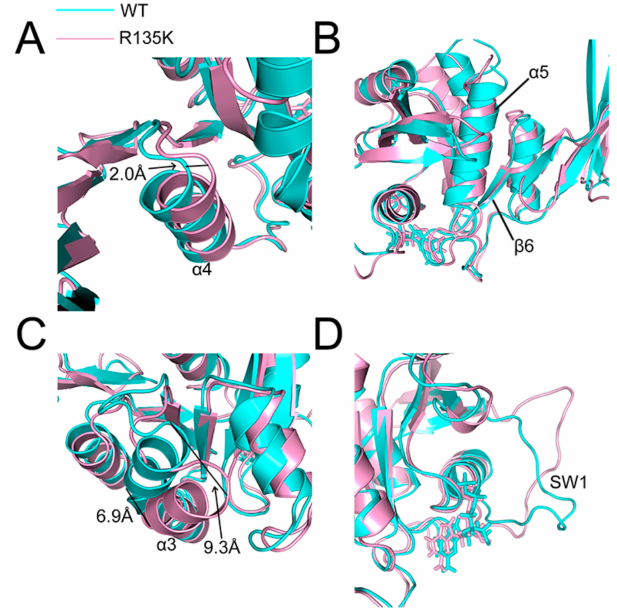
Figure 8. Detailed superposition structures analysis of α 4 helix ( A ); α 5 helix and β 6 sheet ( B ); α 3 helix ( C ) and SW1 ( D ). Wild type H-Ras–NS1 complex is colored in cyan, while R135K H-Ras–NS1 complex is in pink.